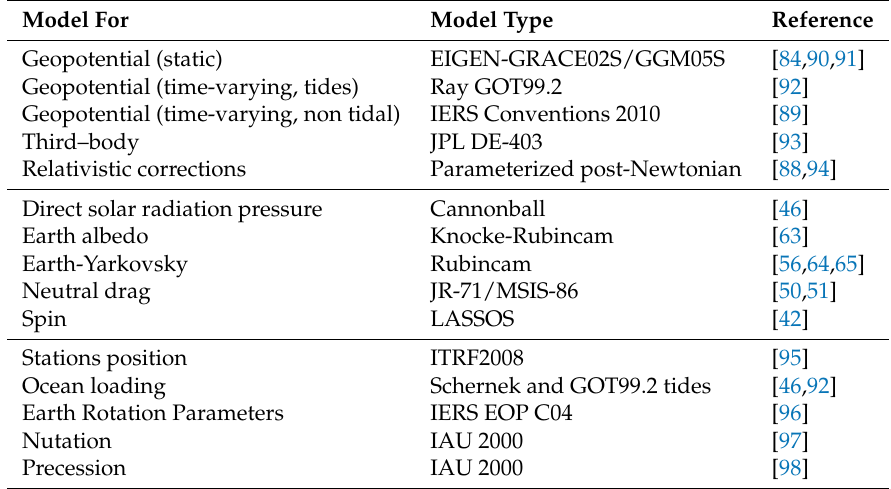
Table 2. Models currently used, within the LARASE research program, for the analysis of the orbit of the two LAGEOS and LARES satellites. The models are grouped in gravitational perturbations, non-gravitational perturbations and reference frames realizations.